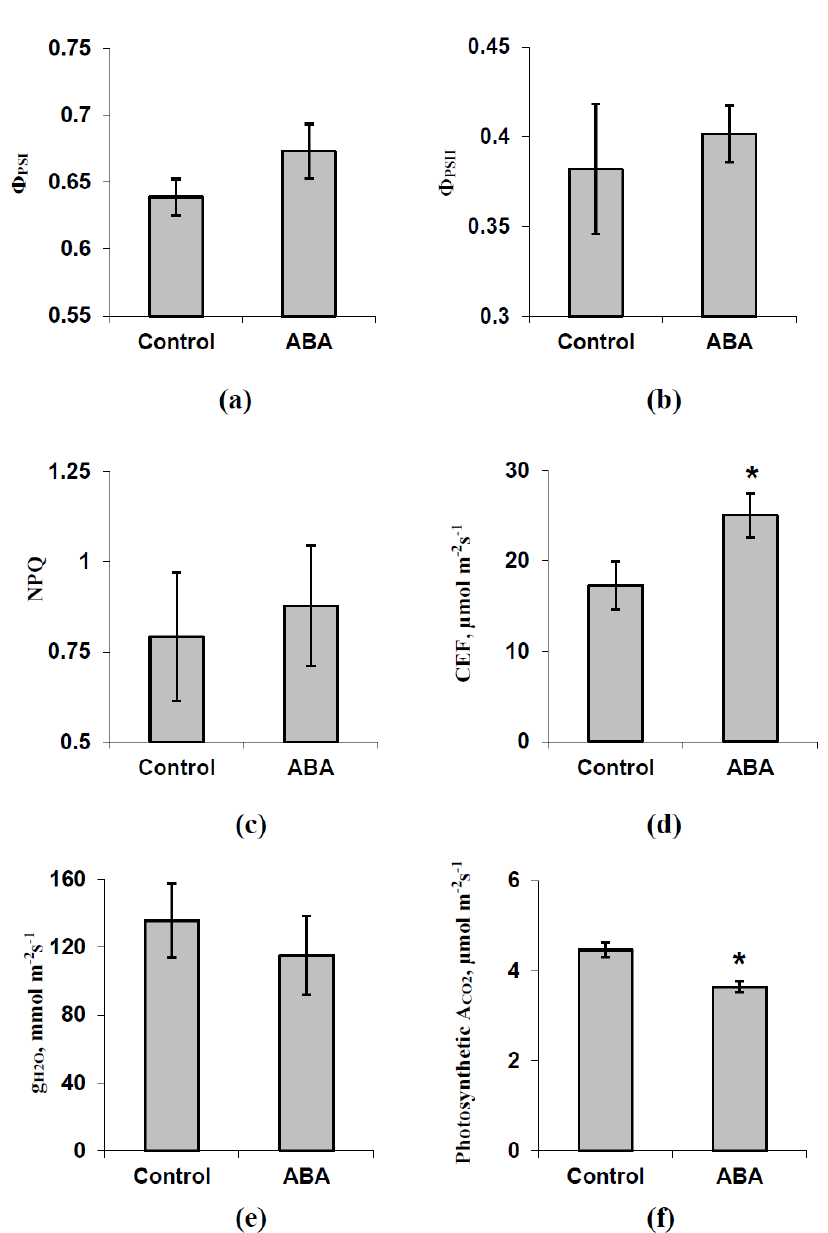
Figure 2. Quantum yields of photosystems I ( Φ PSI ) ( a ) and II ( Φ PSII ) ( b ), the non-photochemical quenching of chlorophyll florescence (NPQ) ( c ), the cyclic electron flow around photosystem I (CEF) ( d ), the leaf water conductance (g H2O ) ( e ), and the photosynthetic assimilation of CO 2 (A CO2 ) ( f ) after the ABA treatment in pea seedlings ( n = 5-15). The ABA treatment of seedlings was performed by spraying them with aqueous solutions (10 − 5 M) 1 day before photosynthetic measurements; control plants were treated with equal volumes of water. Photosynthetic parameters and leaf water conductance were measured after 10 min of illumination by blue actinic light (239 µ mol m − 2 s − 1 ) in the second mature leaf. *, difference between experiment and control plants is significant ( p < 0.05).